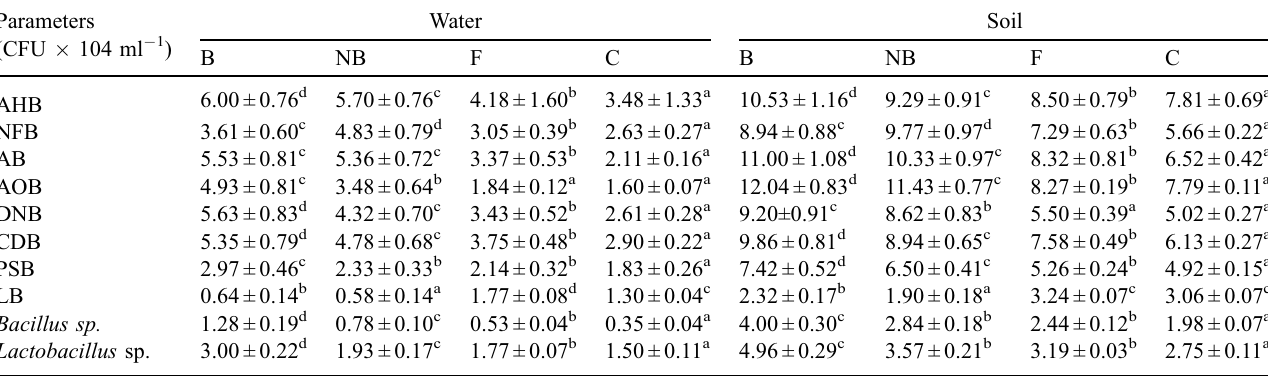
Table 7. Microbial populations in water and soil in L. vannamei culture (mean ±standard error; n =3). Parameters (CFU (cid:3) 104 ml (cid:2) 1